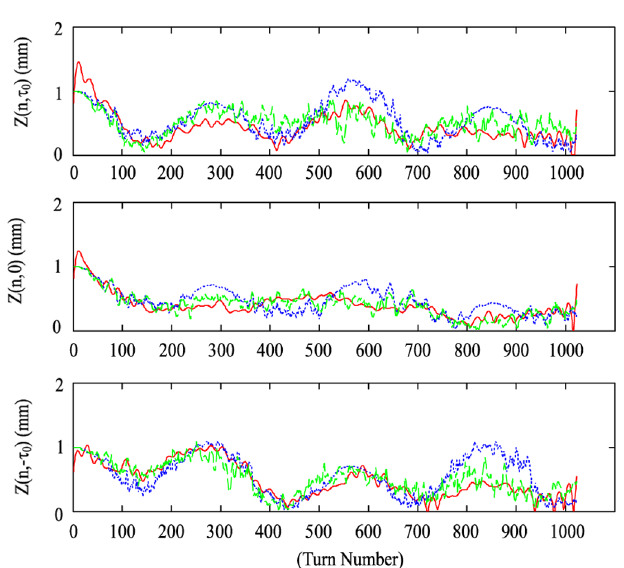
FIG. 11. (Color) Plot of measured and simulated envelope of Z (cid:3) n; (cid:1) (cid:4) versus n turns. Shown is the transverse (horizontal) envelope of turn-by-turn data of head (top), center (middle), and tail (bottom) after a 1 mm kick. The head and tail are 4 nsecs (cid:5) 4 nsecs ) away from the bucket center. Shown is the actual ( (cid:1) 0 envelope data (red trace) overlaid with 1000 particle simulation (cid:5) 12 cm 1 : 5 and chromaticity (cid:4) (cid:5) with resistive wall wake W 1 ? (cid:5) 3 ns only (blue trace). Simulations with the 3 : 733 and (cid:8) (cid:1) addition of second order chromaticity of (cid:4) 0 (cid:5) 3000 (green trace) are also overlaid.